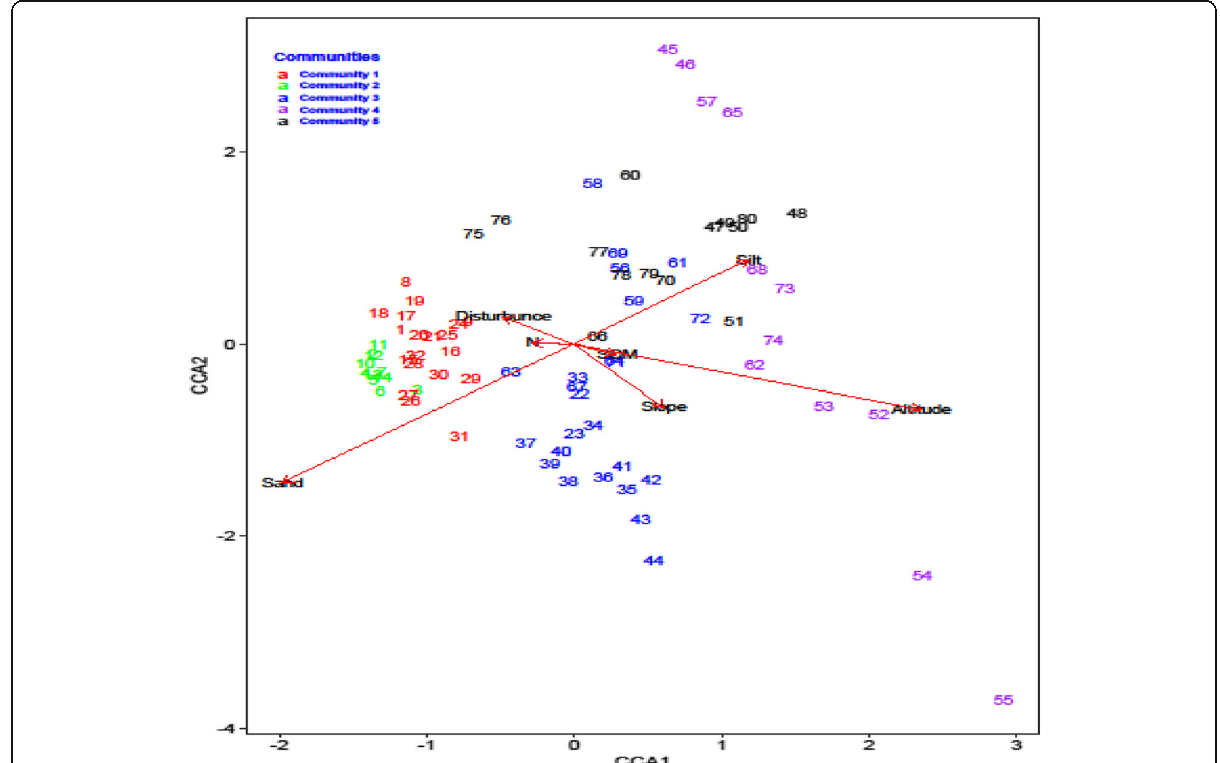
Fig. 4 CCA displaying sites constrained by some selected environmental variables and community types identified by different colors. * N total nitrogen; SOM soil organic